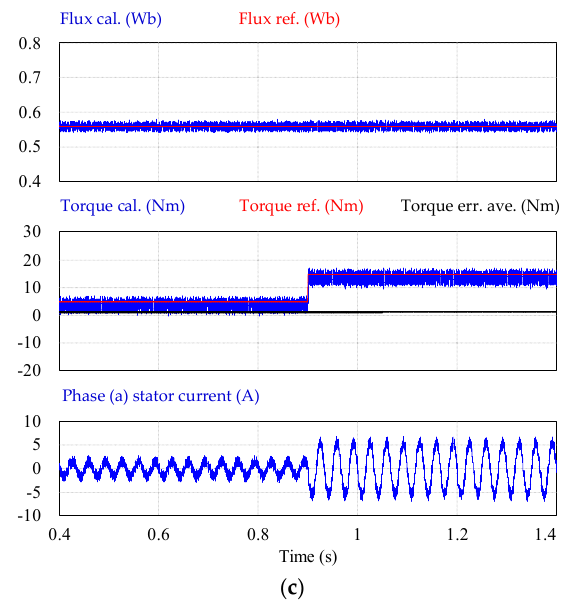
Figure 10. Simulation results of the transient-state operation: ( a ) conventional four-level HTC at 150 r / min; ( b ) conventional four-level HTC at 600 r / min; ( c ) proposed four-level HTC at 600 r / min.